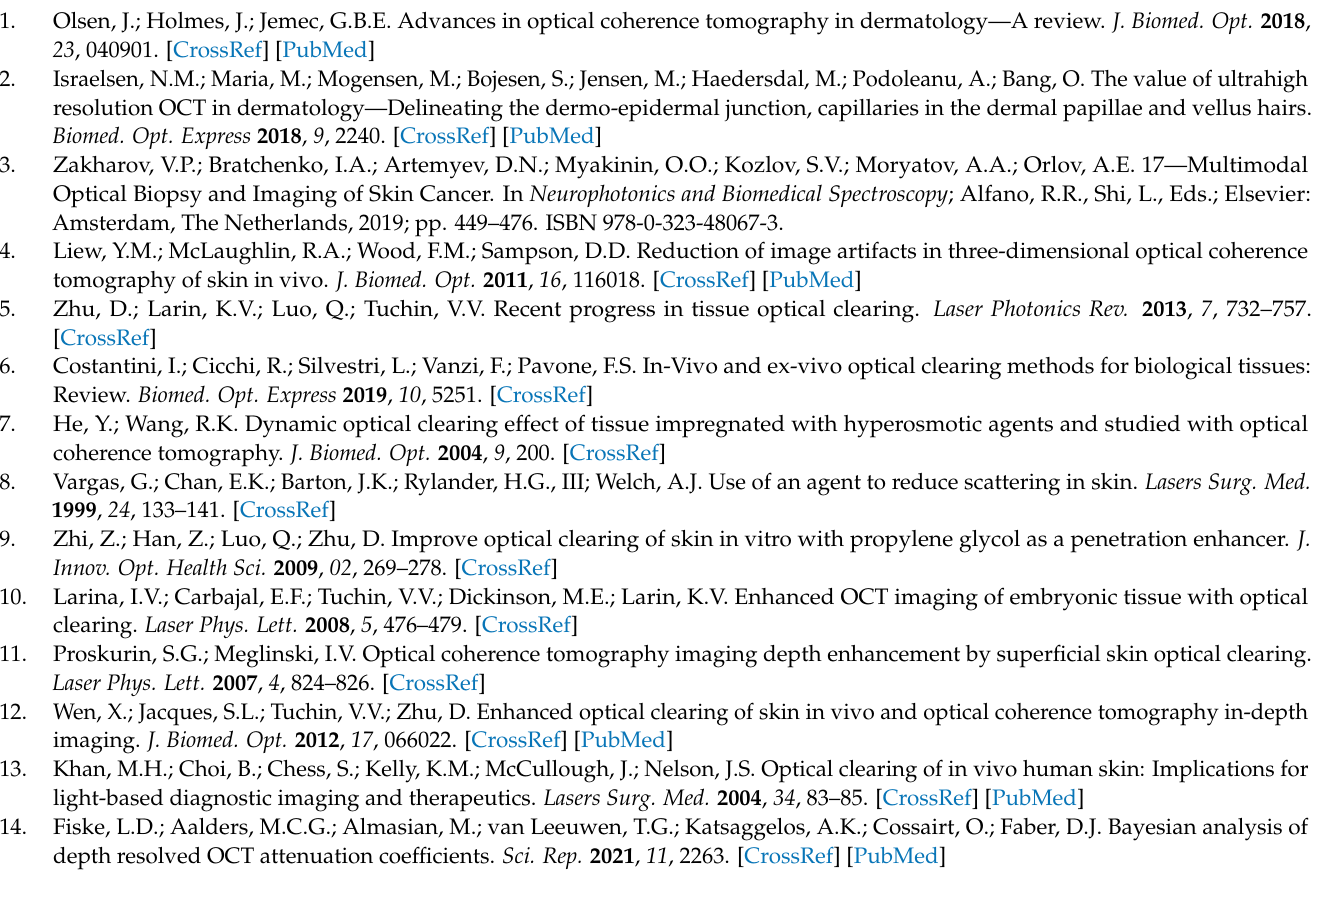
Table S2: Mean epidermal thickness values with SD estimated by the iterative analysis of four OCT image ROIs at time points t 1 and t 2